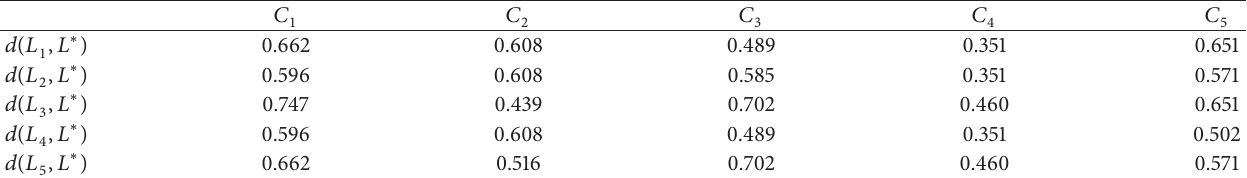
Table 8: Distance with positive-ideal solution with respect to each criterion.